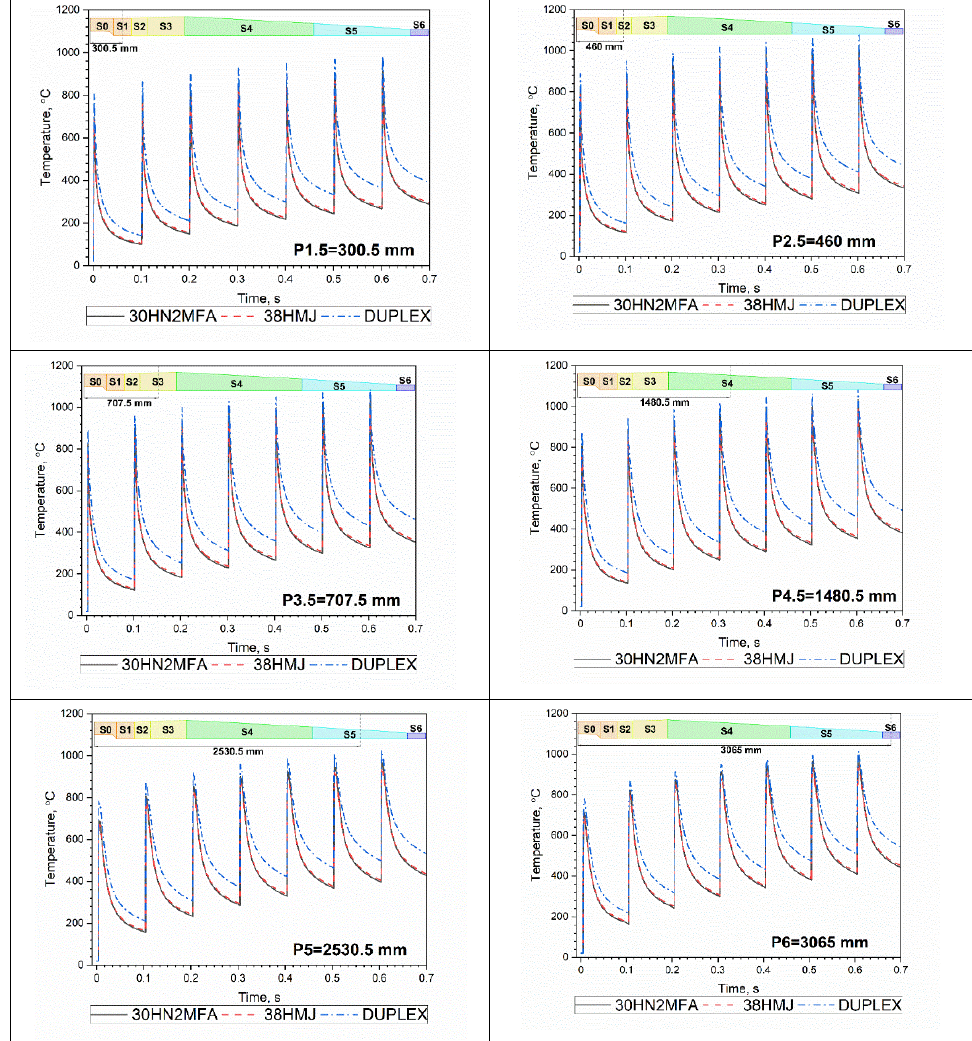
Figure 9. Temperature distribution T i ( t , r in , z ) of the barrel’s inner surface at the 6 zones S1 to S6 ( z in the middle of each zone) for the sequence of seven shots for the selected steels. The signs: P1.5—in the middle of the S1 zone, P2.5—in the middle of the S2 zone, etc. The lowest temperature, i.e., the lowest peak temperature, for 38HMJ and 30HN2MFA steel was the same for each shot in a series of seven shots. However, in the case of DUPLEX steel, this temperature was higher for each shot in a series of seven shots compared to the 38HMJ and 30HN2MFA